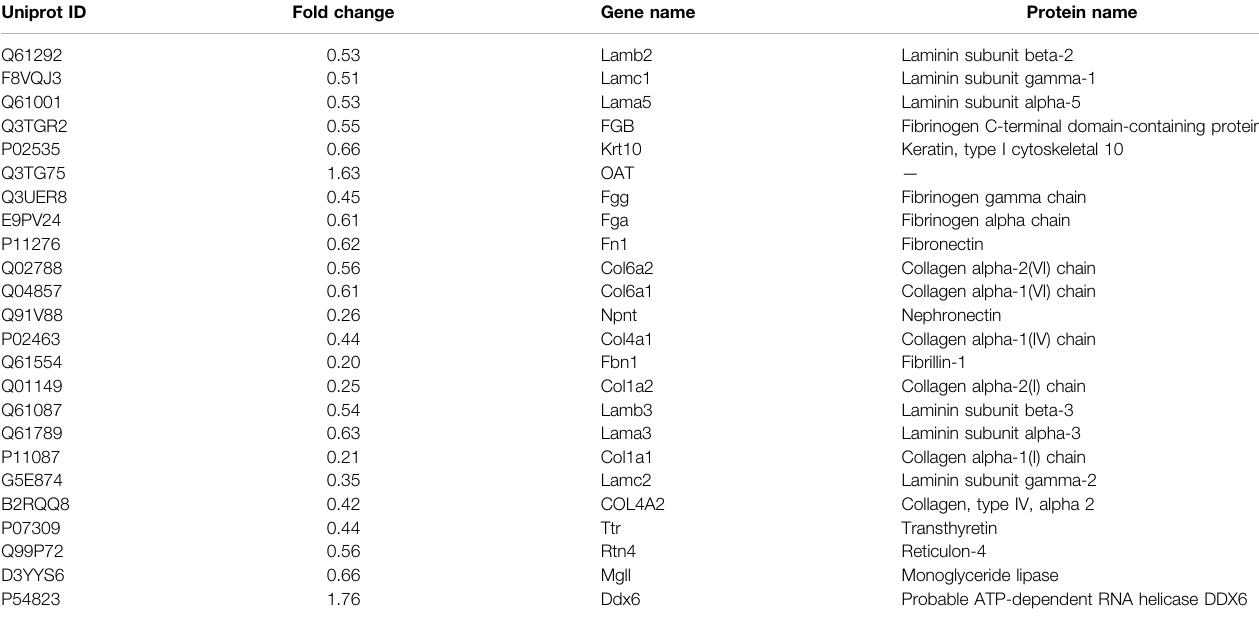
TABLE 5 | The DAPs of lung in the GBFXD group compared with the model group. Uniprot